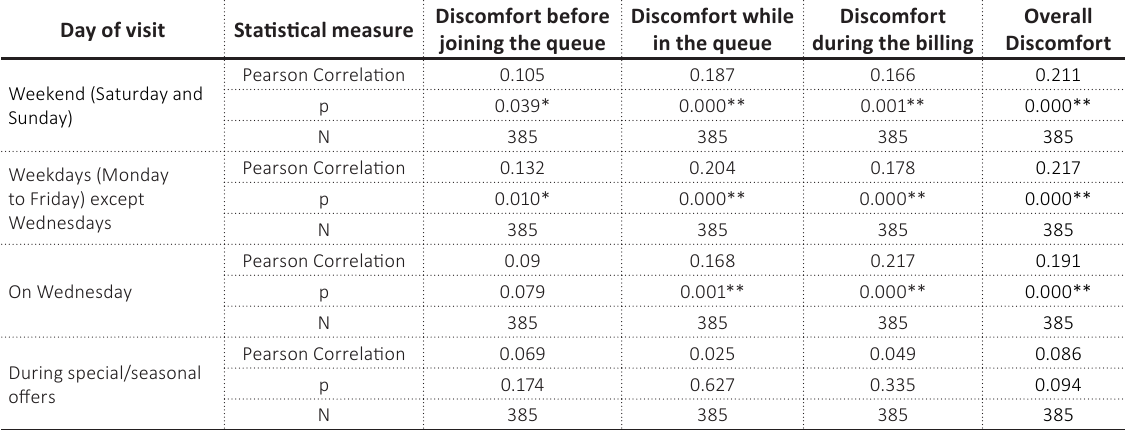
Table 6. Correlation among idle wait durations and